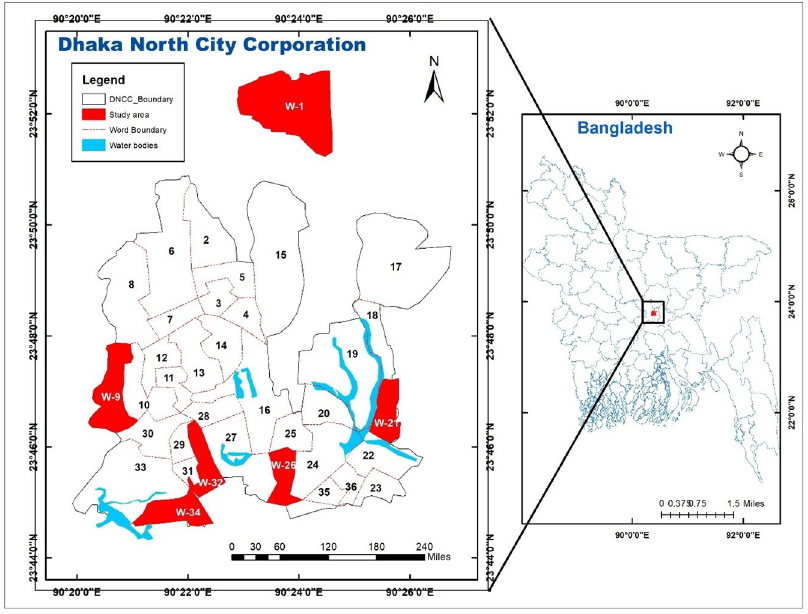
Fig 1. Sampling location map of the study in Dhaka North City Corporation